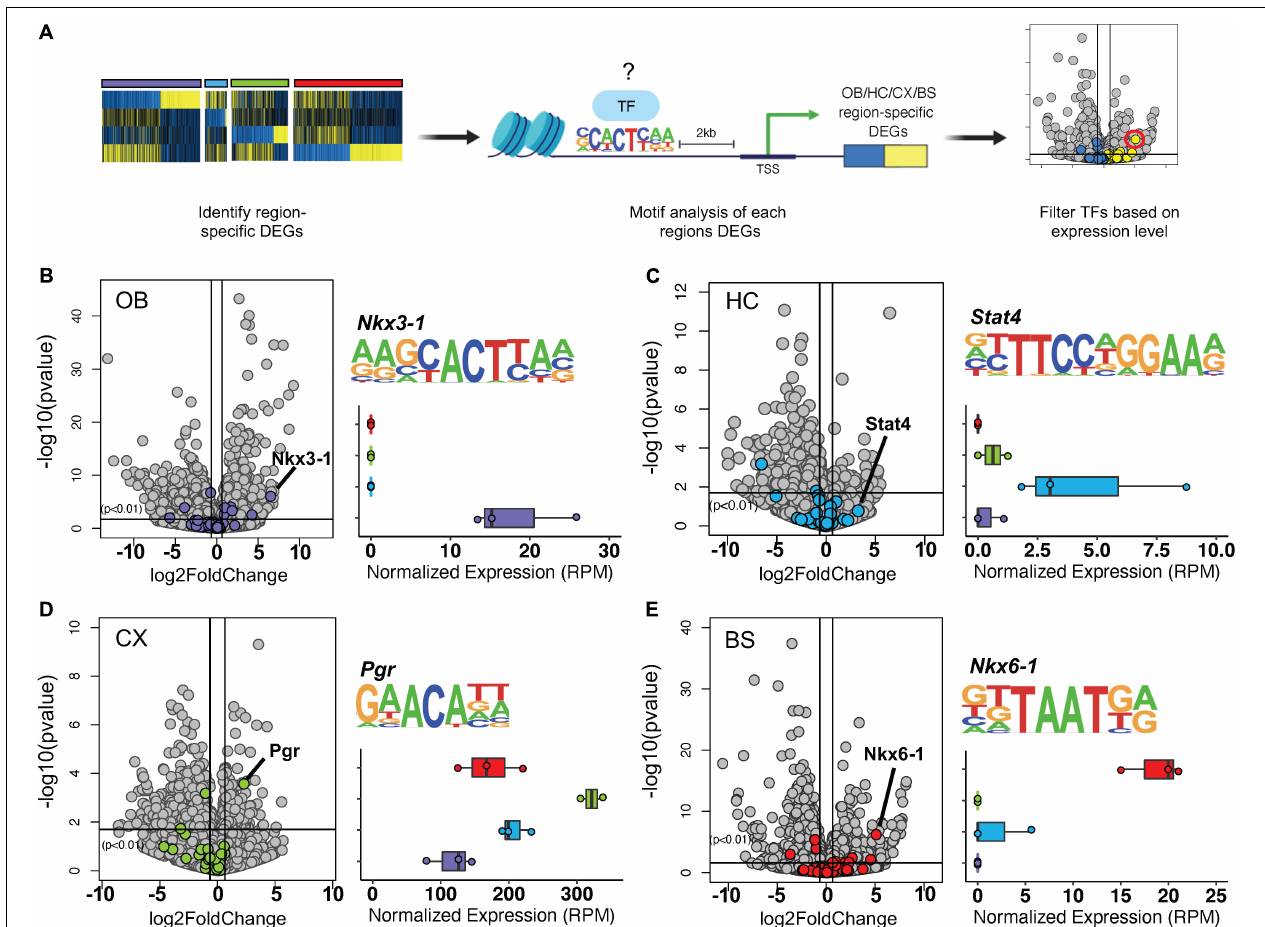
FIGURE 4 | Transcription factor motif enrichment is regionally distinct. (A) Schematic of bioinformatic approach to identify region-specific transcription factors. (B–E) Volcano plot showing significance versus log2 fold change. Transcription factor motifs enriched in each region’s DEGs colored. Most upregulated statistically significant transcription factor motif sequence and normalized expression shown. (B) Nkx3-1 in OB, (C) Stat4 in HC, (D) Pgr in CX, (E) Nkx6-1 in BS. p -value < 0.01.